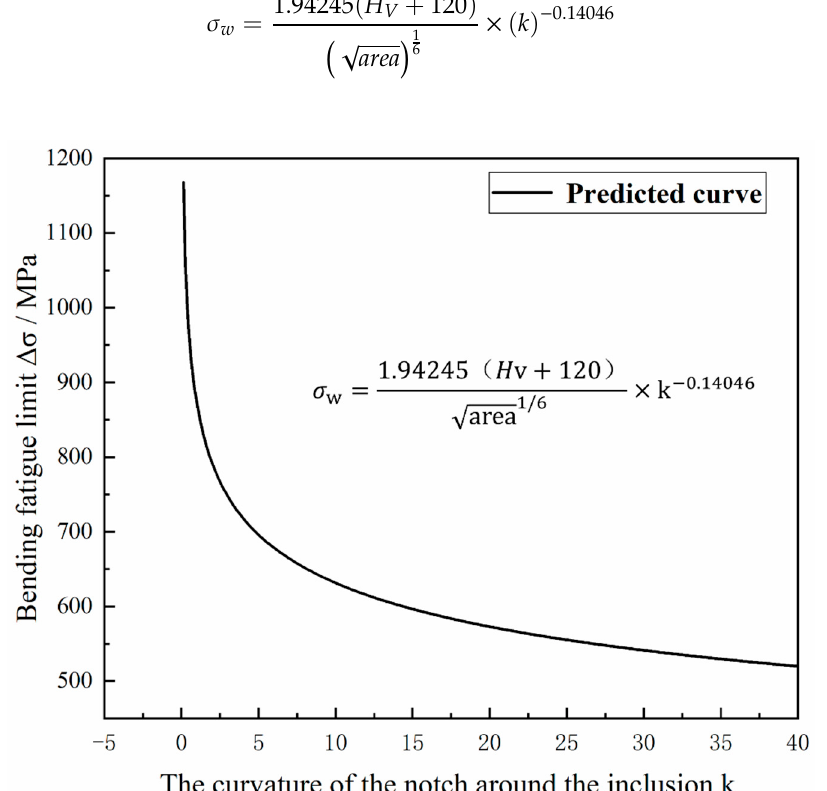
Figure 15. New model fitting curve.